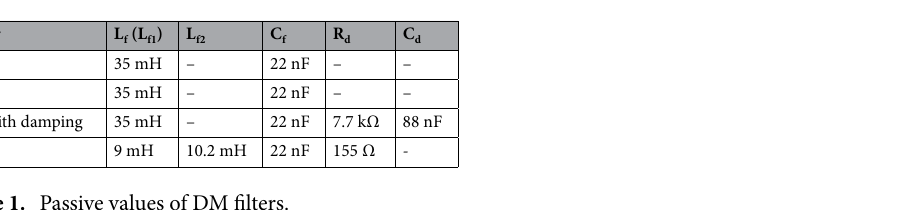
Table 1. Passive values of DM